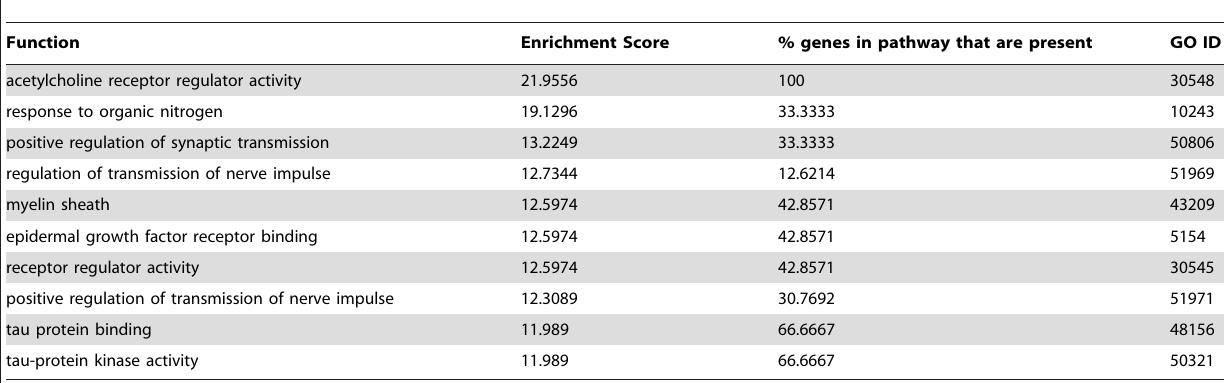
Table 1. Top 10 enriched gene ontology terms in QK knockdown samples.